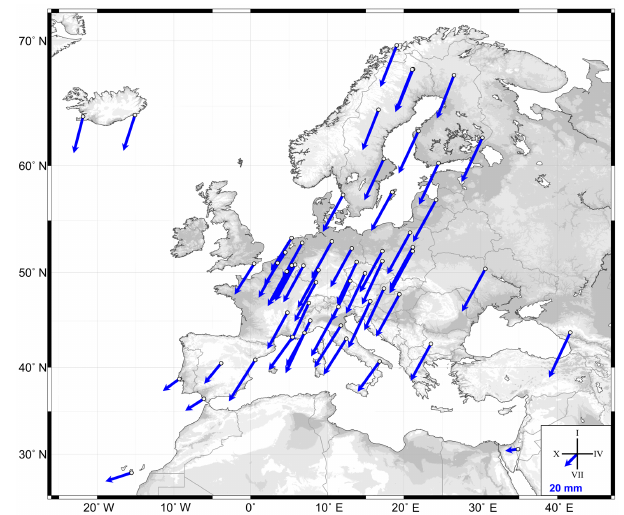
Figure 3. Amplitude and phase shift for the annual oscillation for the ZTD time series derived from the Repro2